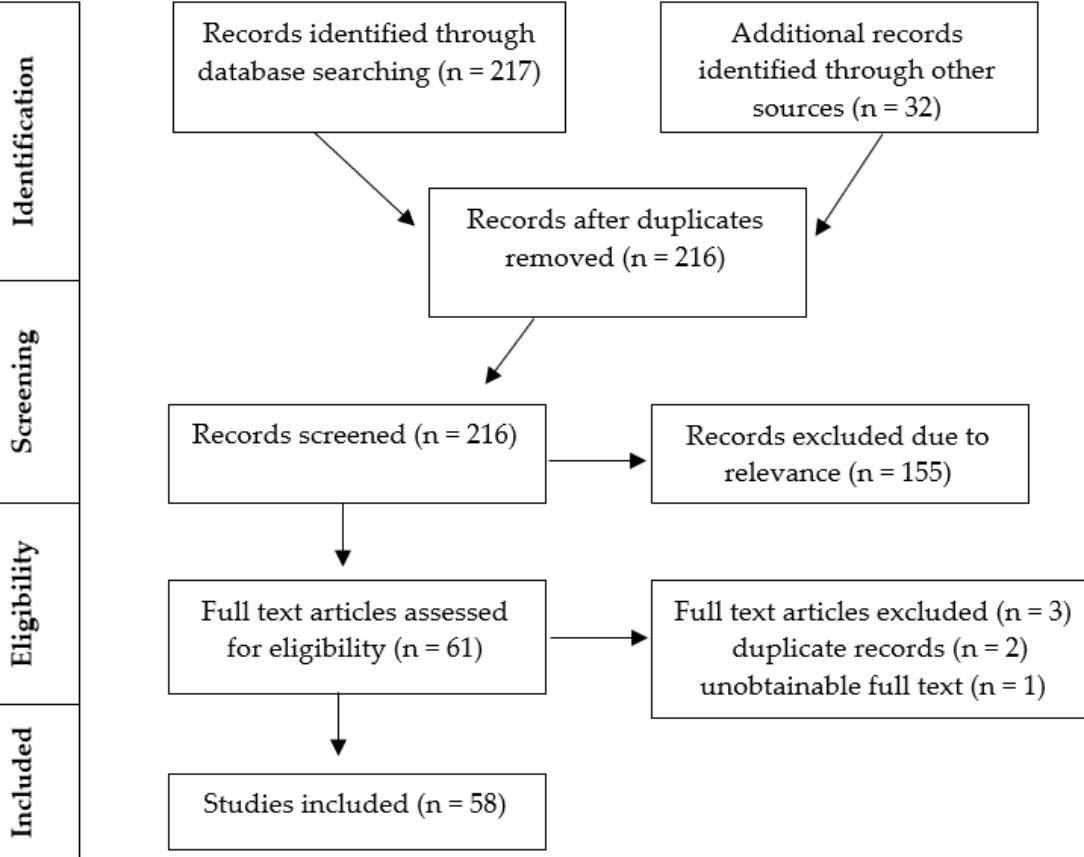
Figure 1. A PRISMA flow diagram depicting the scoping-review process.